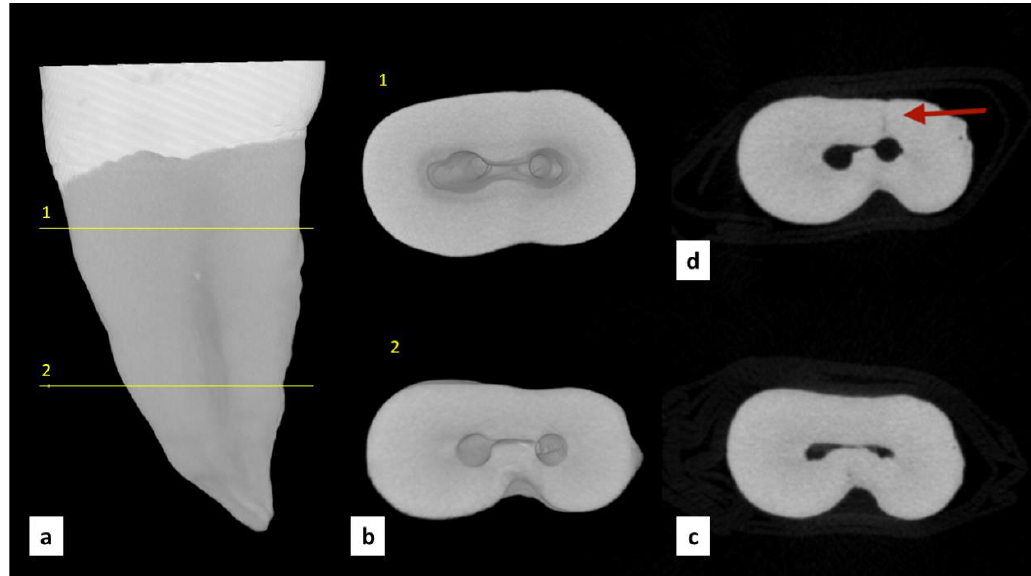
Figure 2. Three-dimensional representation of the Micro-computed tomography (MicroCT) scan of the maxillary premolar instrumented using TruShape. ( a ) Lateral view of the 3D model of the maxillary premolar. ( b ) Coronal view of the 3D model of the maxillary premolar. ( c ) Cross section of the canals before instrumentation. ( d ) Cross section of radicular canals after instrumentation with the arrow pointing at the newly formed microcrack.